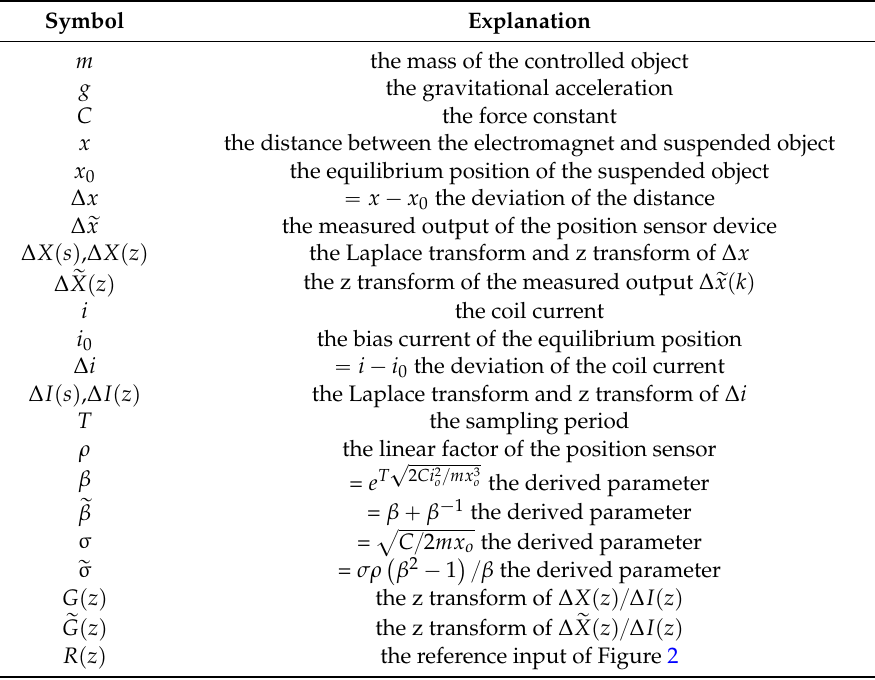
Table 1. Symbol summary for a